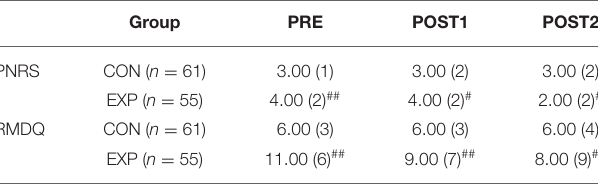
TABLE 2 | Effect of spinal thermal massage on PNRS and RMDQ scores. TABLE 3 | Effect of spinal thermal massage on antioxidant